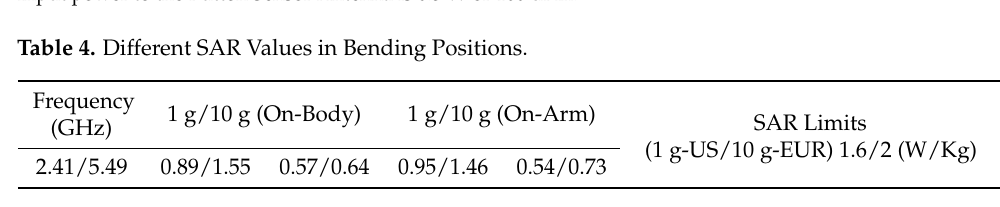
Table 5. Summary Performance of the Proposed Button Sensor Antenna in Flat Position.